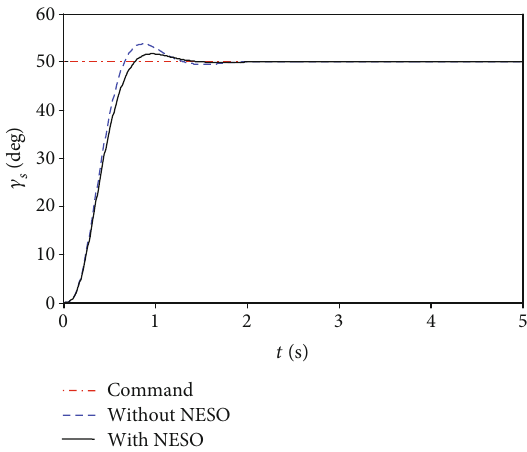
Figure 8: Bank angle tracking